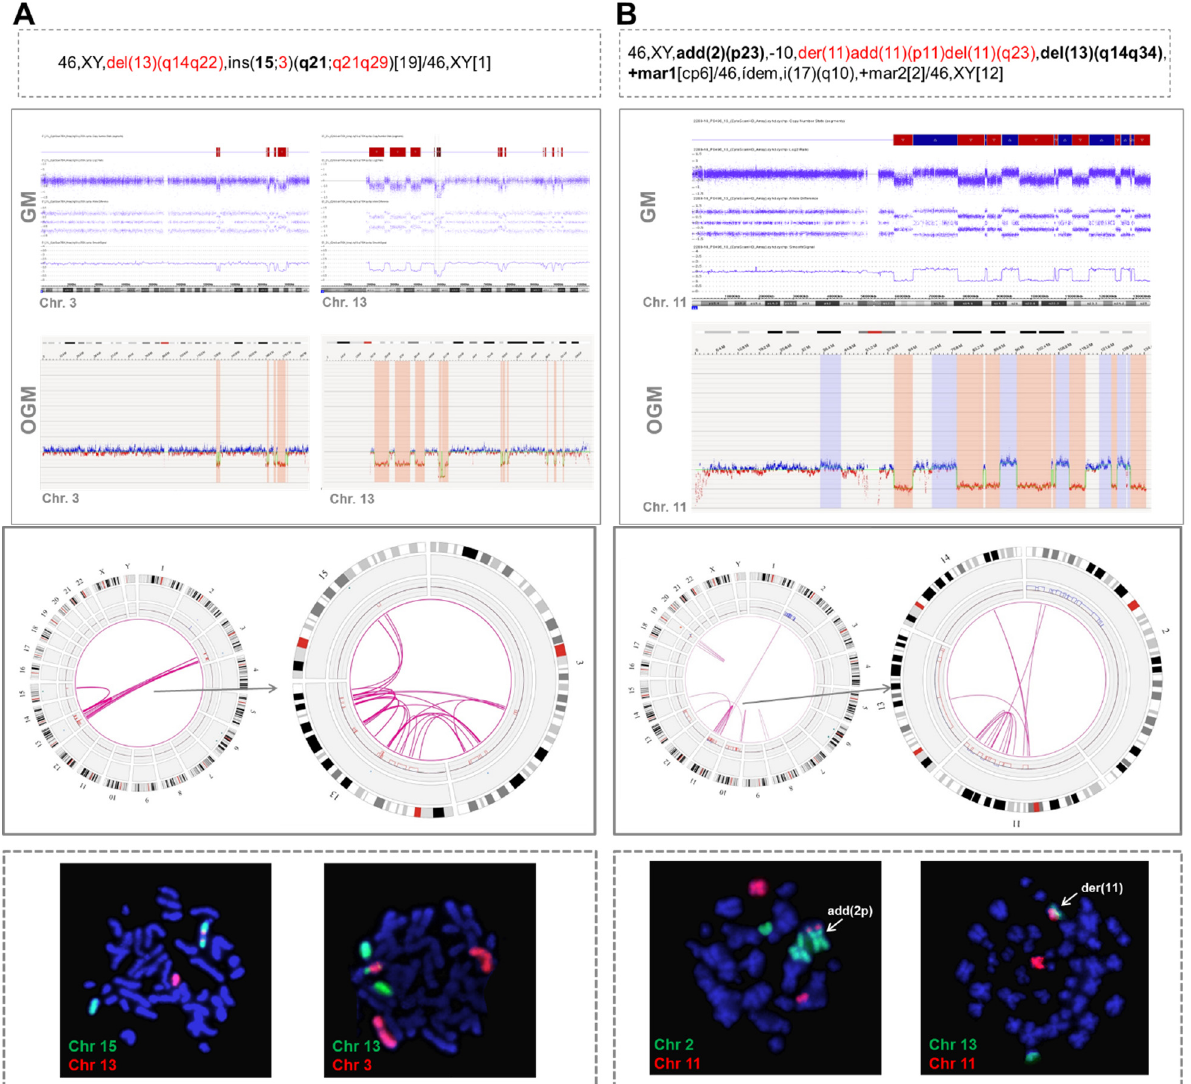
Figure 2. Two examples of cases with chromothripsis analyzed by optical genome mapping showing rearrangements between chromothriptic and non-chromothriptic chromosomes. ( A ) Patient with chromothripsis in chromosomes 3 and 13 (case #31). OGM detected 10 rearrangements between chromosomes 3 and 13 and four rearrangements between chromosomes 13 and 15. Whole chromosome FISH painting (WCP) revealed the presence of material from both chromosomes 3 and 13 inserted in chromosome 15. ( B ) Patient with chromothripsis in chromosome 11 (case #17). OGM revealed the presence of intra-chromosomal translocations and several additional rearrangements involving chromosomes 2, 13 and 14. Notably, t(2;11) and t(11;13) were validated by WCP. Con- versely, despite showing only one line in the Circos plot, three parallel t(11;14) were identified by OGM and could not be validated by WCP. However, they could not be ruled out with certainty as true translocations since the rearranged fragment located between the breakpoints was very small